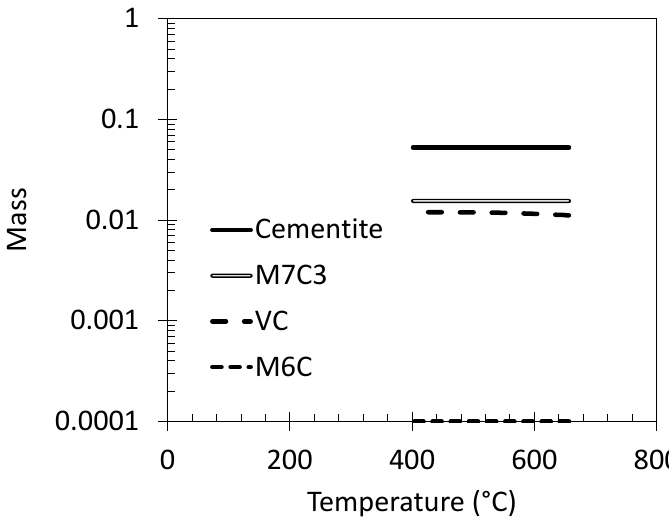
Figure 4. Calculated equilibrium mass fractions of carbides as a function of tempering temperature.